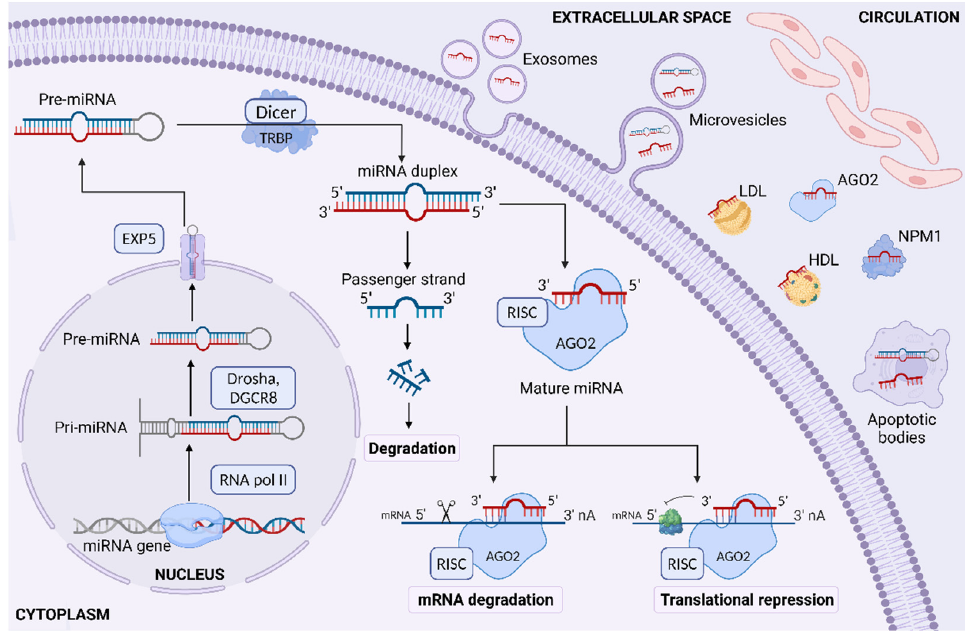
Figure 1. Canonical pathway of miRNA biogenesis in humans. miRNA genes are transcribed by RNA pol II into pri-miRNA transcripts in the nucleus. Pri-miRNA is processed to pre-miRNA with the Drosha enzyme, and then it is transported to the cytoplasm by EXP5. Dicer endonuclease cleaves it to a short miRNA duplex. Mature miRNA, as a part of the RISC complex, binds with the 3 ′ -untranslated region of target mRNA on different complementarity leading to mRNA degradation or translational repression. Both pre-miRNA and mature miRNA can be released passively or actively into the extracellular space in apoptotic bodies, exosomes, microvesicles, or in the complexes with AGO2, NPM1, HDL, and LDL. miRNA—microRNA; RNA pol II—RNA polymerase II; Pri-miRNA—primary miRNA; Pre-miRNA—precursor miRNA; DGCR8—DiGeorge syndrome Critical Region 8; EXP5—exportin 5; TRBP—trans-activation response RNA binding protein; AGO2—Argonaute 2; RISC—RNA-induced silencing complex; mRNA—messenger RNA; NPM1—nucleophosmin 1; HDL—high-density lipoprotein; LDL—low-density lipoprotein. Created with BioRender.com.